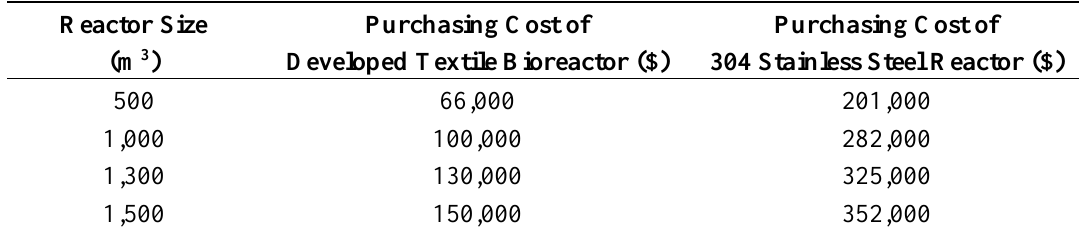
Table 3. Purchasing cost of developed textile bioreactors and 304 stainless steel